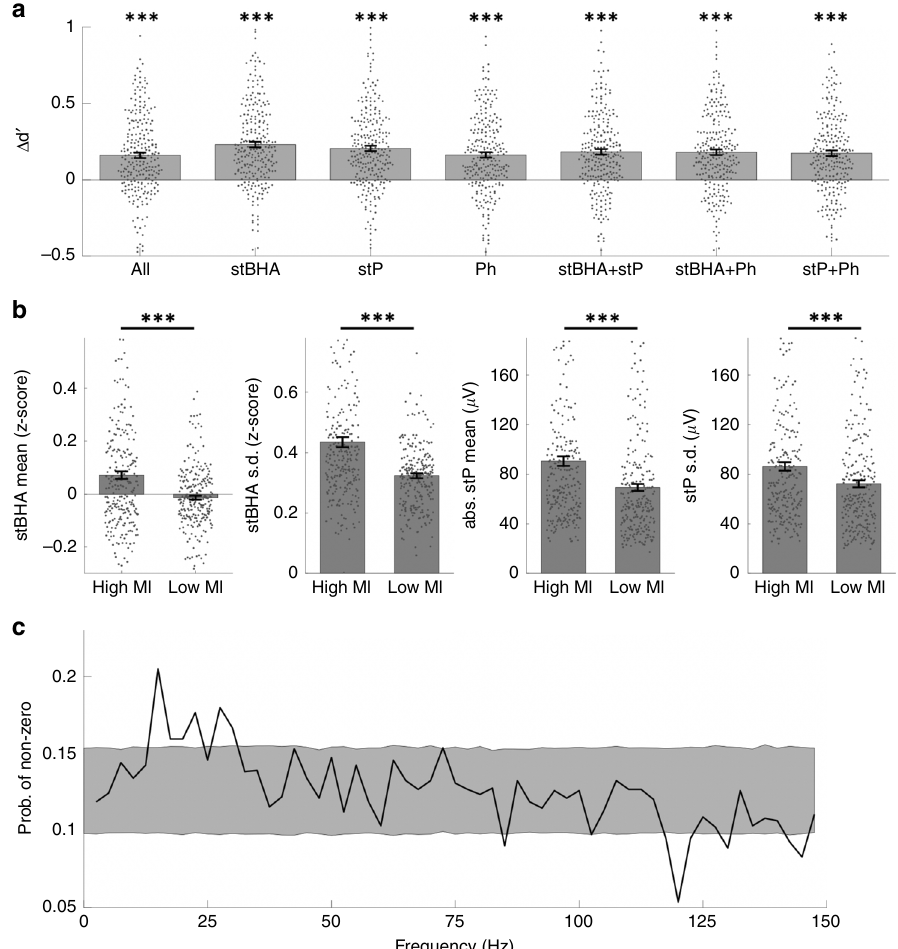
Fig. 3 Different aspects of pre-stimulus features contributed to the modulation model. a From left to right, bar plot for the averaged increasement classi fi cation d ’ from post-stimulus only classi fi cation across all electrodes for: ( all ) including all pre-stimulus features, ( stBHA ) including the pre-stimulus stBHA features only, ( stP ) including the pre-stimulus stP features only, ( Ph ) including the pre-stimulus phase features only, ( stBHA + stP ) including the pre-stimulus stBHA and stP features, ( stBHA + Ph ) including pre-stimulus stBHA and phase features, ( stP + Ph ) including the pre-stimulus stP and phase features. Each sample dot in the plot represents the averaged value from one single electrode, n = 246 samples in total for each plot; data are presented as mean values ± s.e.m.; *** p < 0.001, two-sided paired t -test, Bonferroni correction for multiple repeated tests. (From left to right, p = 6 × 10 − 17 , 3 × 10 − 29 , (2) the standard deviation of z-scored stBHA power, (3) the averaged absolute value of stP, (4) the standard deviation of stP, within [ − 500 − ms, − 100 ms] pre-stimulus time window for low MI and high MI trials in each electrode. Each sample dot in the plot represents the averaged value from one single electrode, n = 246 samples in total for each plot; data are presented as mean values ± s.e.m., *** p <0.001, permutation test. (From left to right, p = 7× 10 − 6 , 2×10 − 8 , 3×10 − 23 , 4×10 − 16 , respectively. c The averaged empirical probability of having non-zero weights in the sparse GLM model for different pre- stimulus phase features of different frequency. Shaded area indicates 95% con fi dence interval under random feature selection. (Source data are provided as a Source Data fi